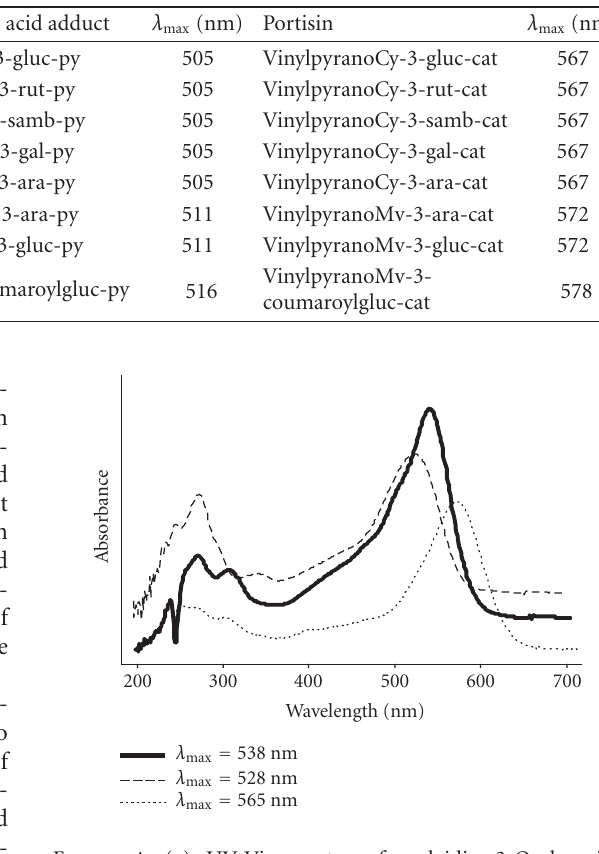
the vinylpyranoanthocyanins of cyanidin 3-O-glucoside (5) and cyanidin 3-O-sambubioside (6), as confirmed by LC-DAD-MS (data not